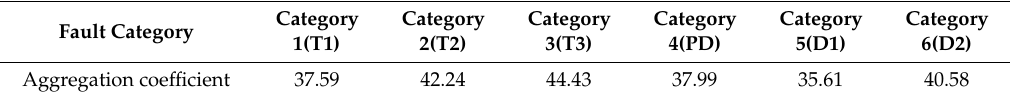
Table 2. Fault aggregation coe ffi cient of data multiplied by coe ffi